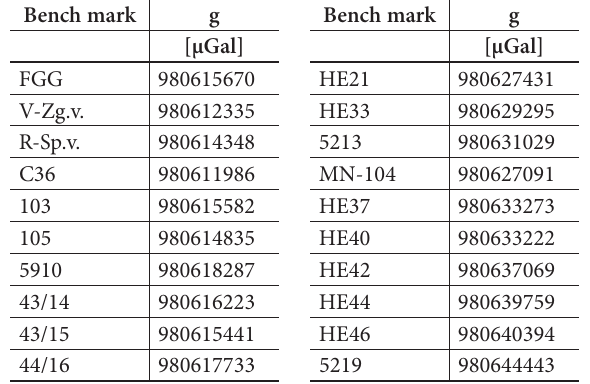
Table 4. Gravitational acceleration measured in the